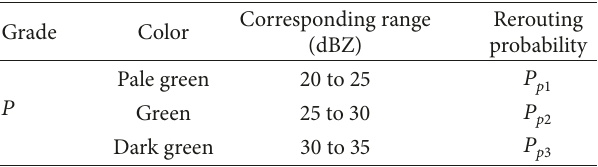
Table 2: Rerouting probabilities when passing the region with 𝑃 - level precipitation.